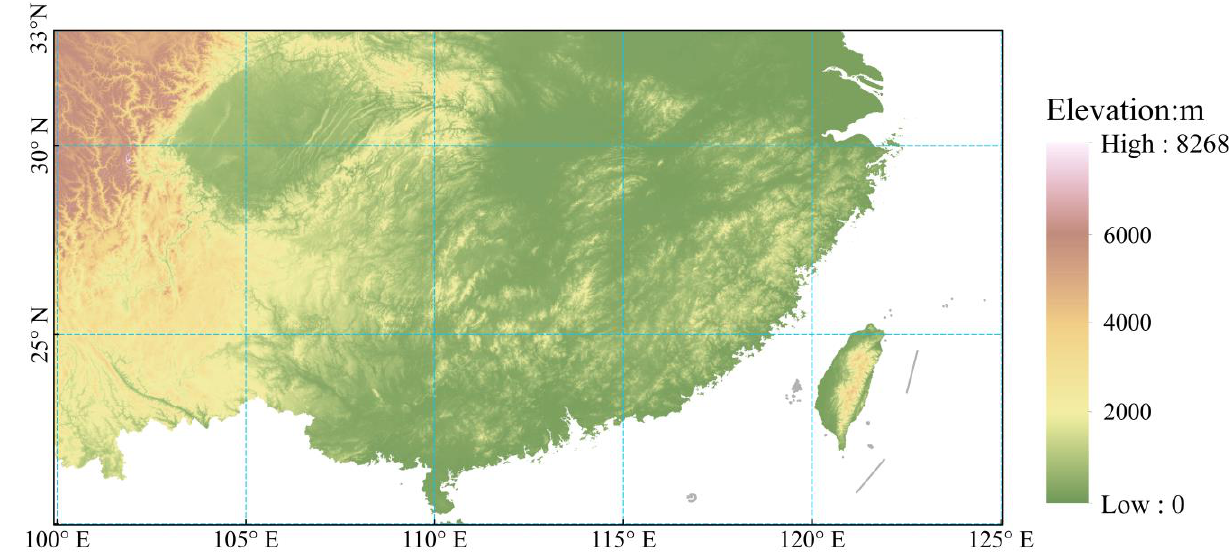
Figure 1. The elevation map of the geographic area studied in this paper.